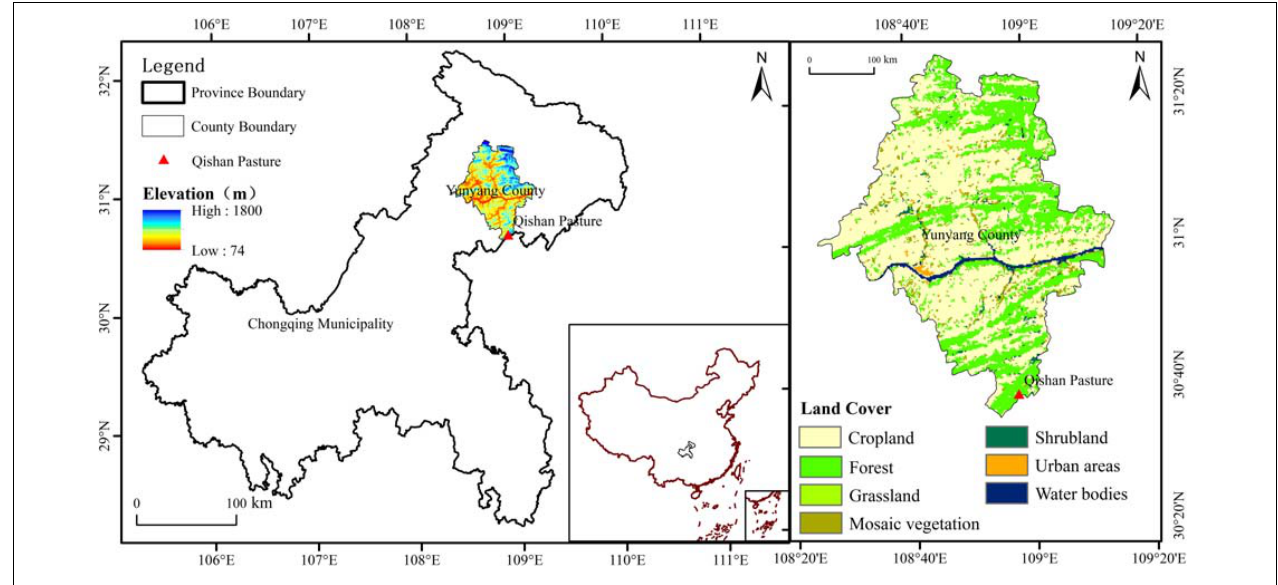
FIGURE 1 | Study site at Qishan Pasture and its location in